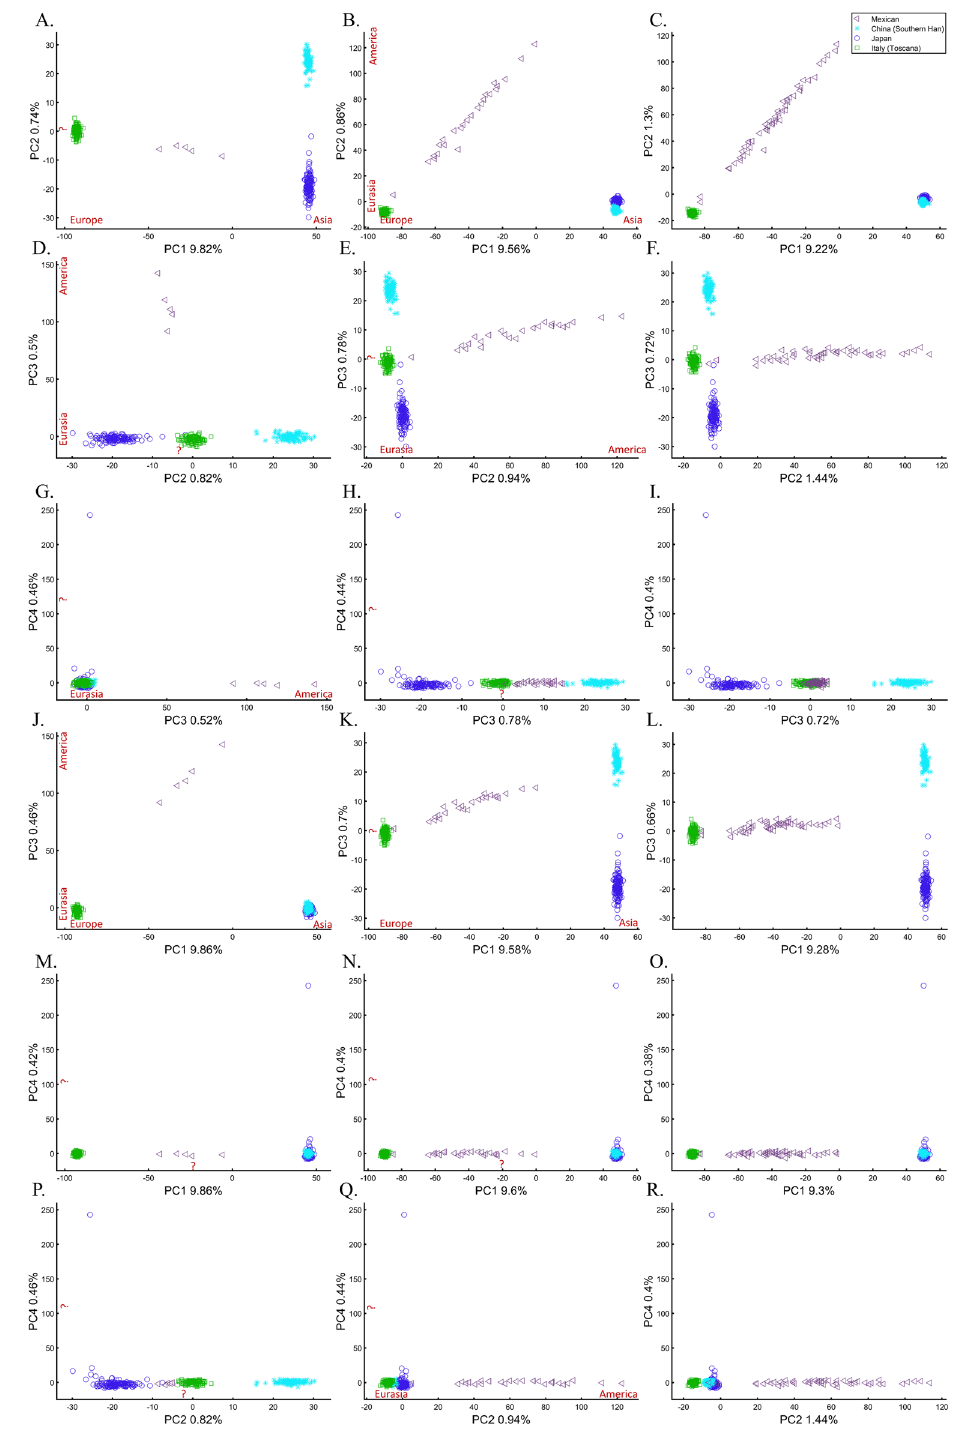
Figure 16. The effect of varying the number of Mexican–American on the inference of genetic distances between Chinese and Japanese using various PCs. We analyzed a fixed number of 135 Han Chinese (CHB), 133 Japanese (JPT), 115 Italians (TSI), and a variable number of Mexicans (MXL), including 5 (left column), 25 (middle column), and 50 (right column) individuals over the top four PCs. We found that the overlap between Chinese and Japanese in PC scatterplots, typically used to infer genomic distances, was unexpectedly conditional on the number of Mexican in the cohort. We noted the meaning of the axes of variation whenever apparent (red). The right column had the same axes of variations as the middle